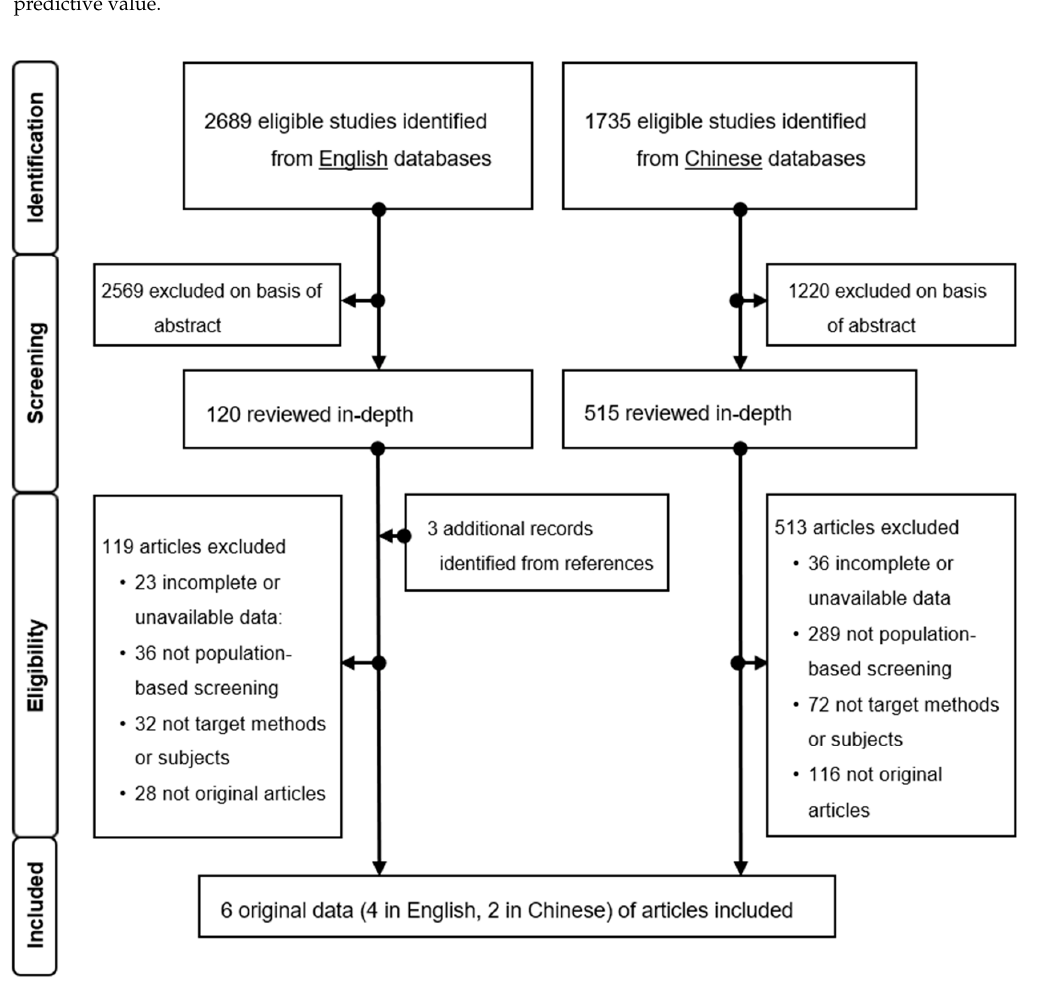
Figure 1. Flow chart of the literature search. Table 2. Diagnostic accuracy of mammography and ultrasound in the included studies.